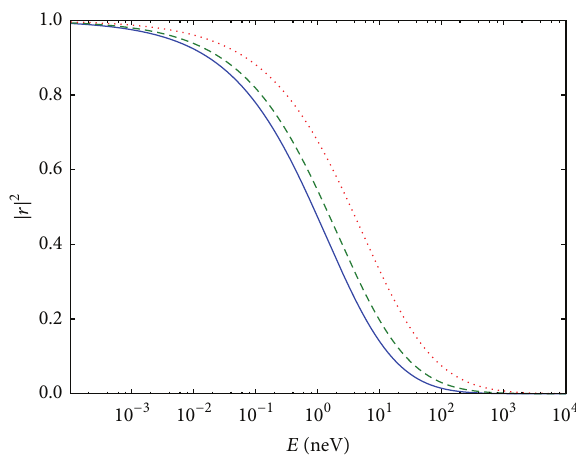
Figure 4: Quantum reflection probability |𝑟| 2 as a function of the energy for antihydrogen atoms on bulk mirrors; from bottom to top: perfect conductor (full line), silicon (dashed line), and silica (dotted